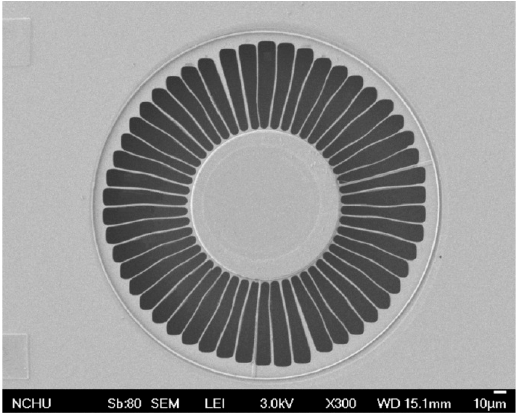
Figure 6. SEM image of an energy harvesting cell.